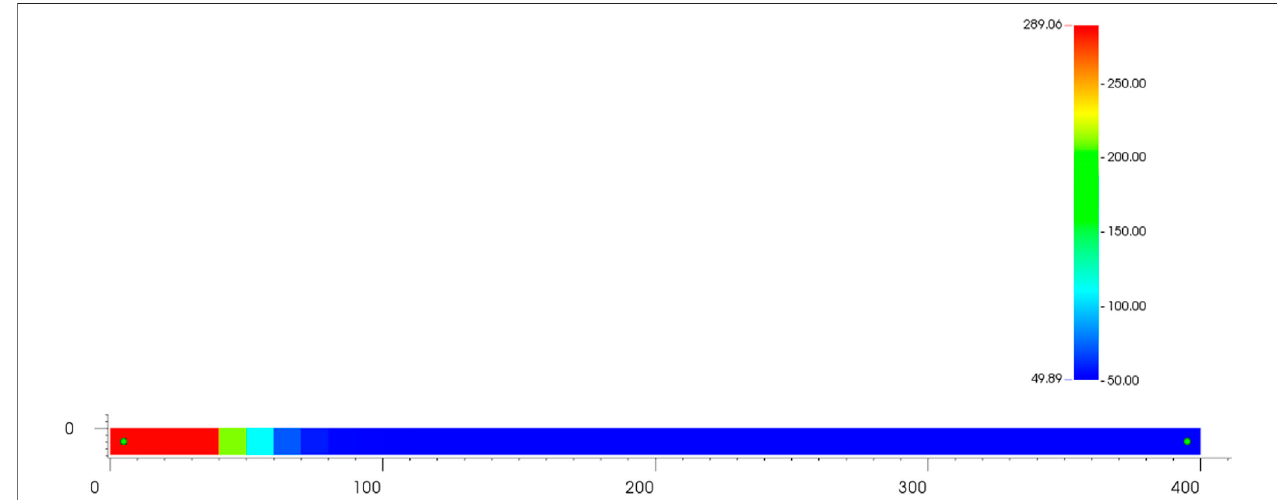
FIGURE 1 | Temperature ( °